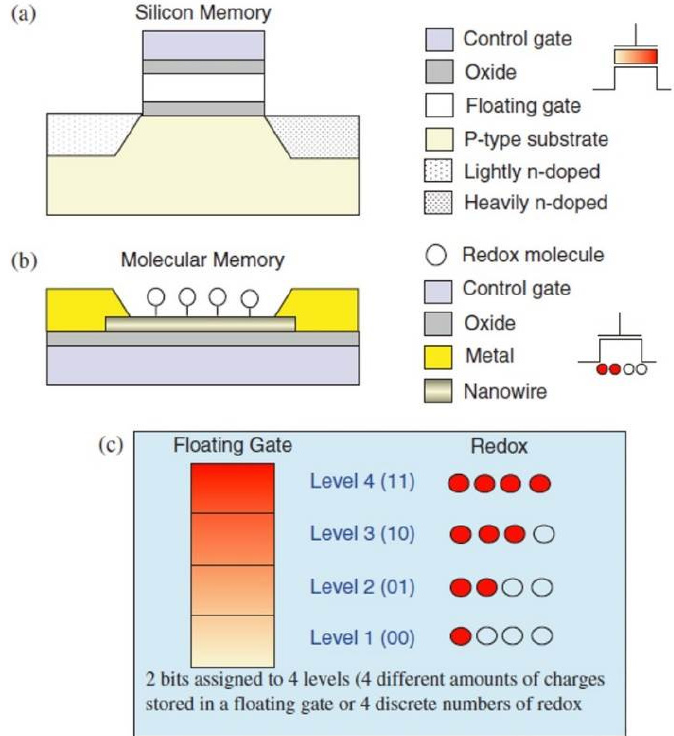
Figure 10. Comparison of designs and operations between ( a ) conventional silicon flash memory and ( b ) molecular memory for multilevel nonvolatile data storage; ( c ) comparison of multilevels in a two-bit silicon flash memory and molecular memory; ( d ) molecular structure of Fe 2+ -terpyridine compound. Reproduced with permission from [53,54], © AIP Publishing LLC, 2004,2007.